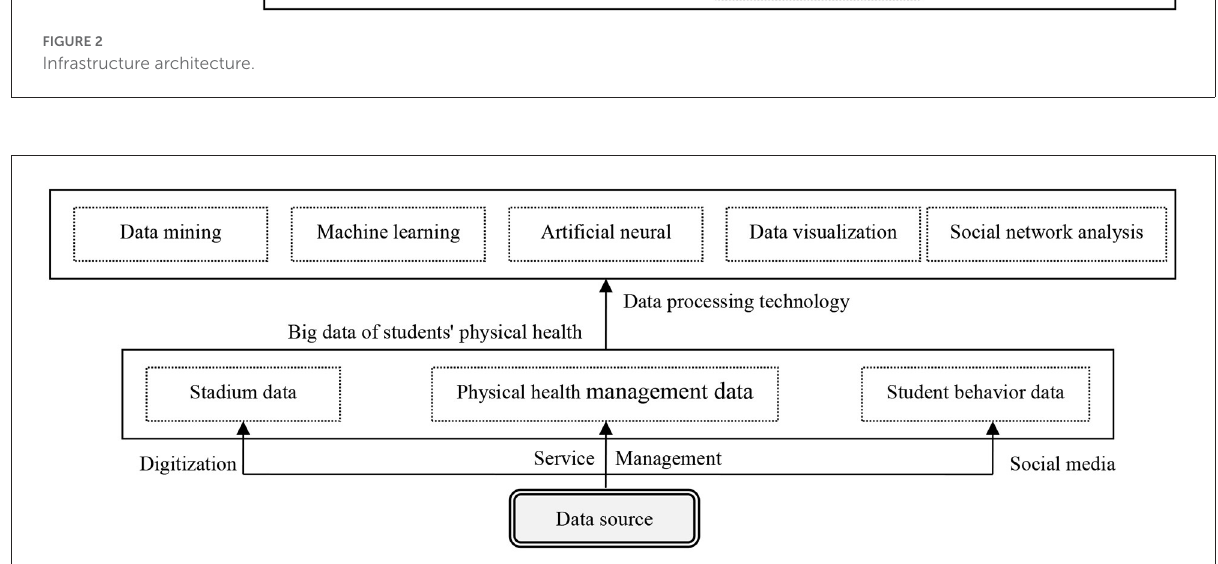
FIGURE3 Data resources and processing